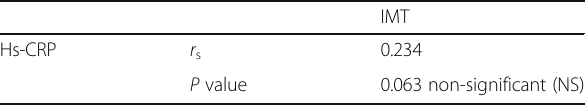
Table 7 Correlation between hs-CRP and